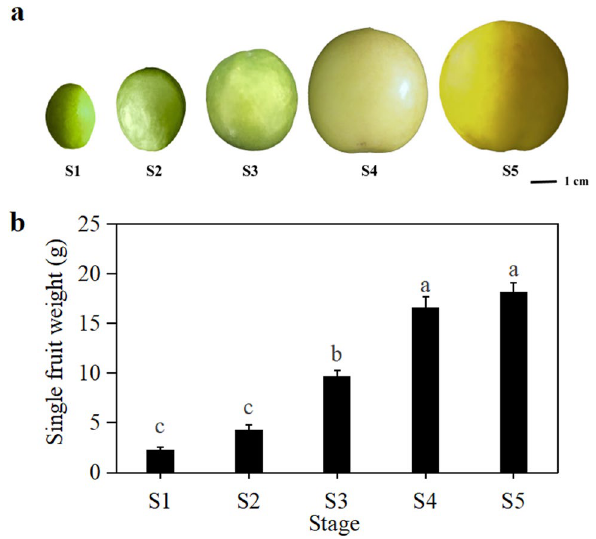
Figure 1. Changes in the fruits and weight of "Luntaibaixing" at different developmental stages (a) Fruit development in 5 stages; (b) Single fruit weight. Note: different letters indicate significant differences at P <